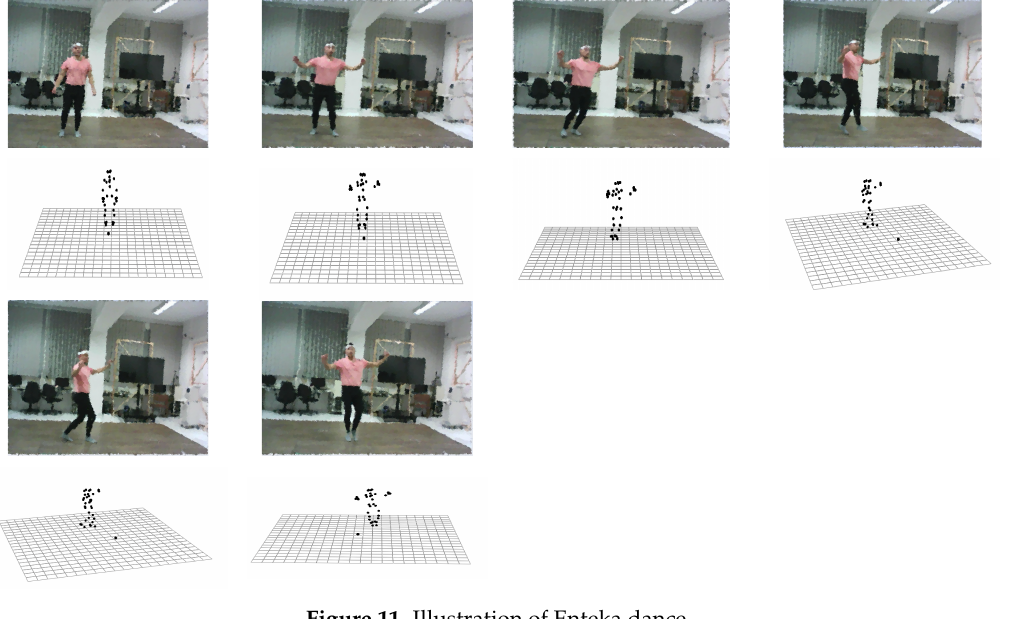
Figure 11. Illustration of Enteka dance.